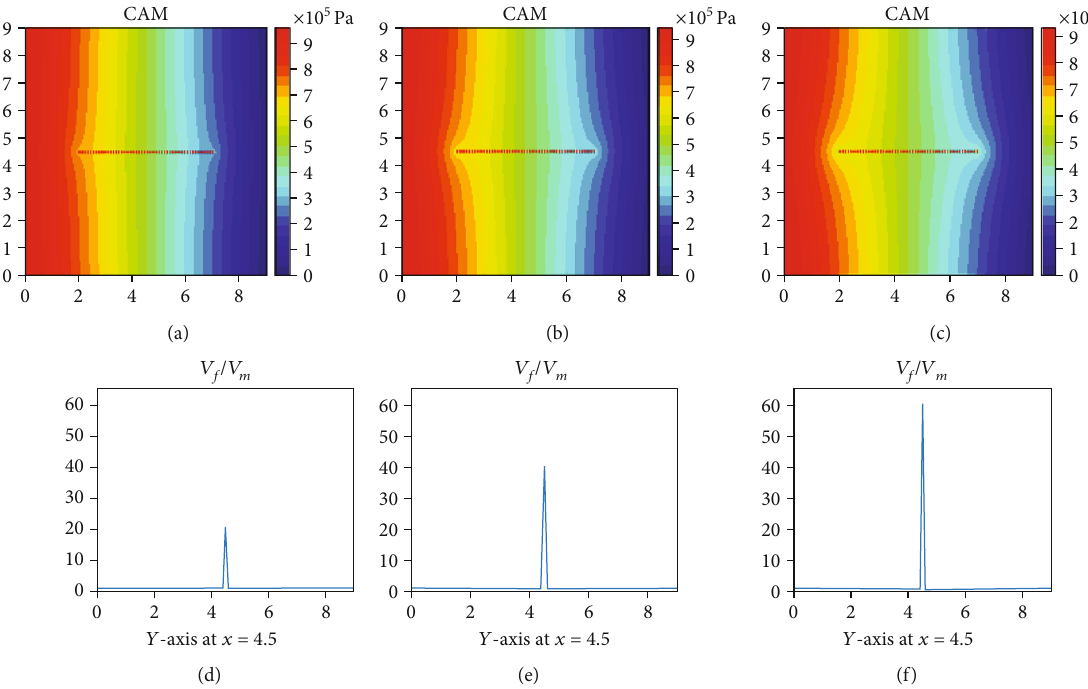
Figure 5: (a, b, and c) Pressure contours (in Pa) generated from CAM. The far- fi eld fl ow moves from left to right with an e ff ective velocity of 1 : 12 × 10 − 6 m/s . (d, e, and f) The respective ratio of fracture velocity ( V f ) to matrix velocity ( V m ) for fractures in (a), (b), and (c). The